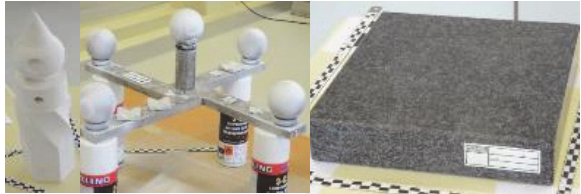
Figure 1. Reference bodies for the investigations of the hand- held scanning systems – Testy (left), cross-shaped body HSBO with spheres (centre) und granite slab